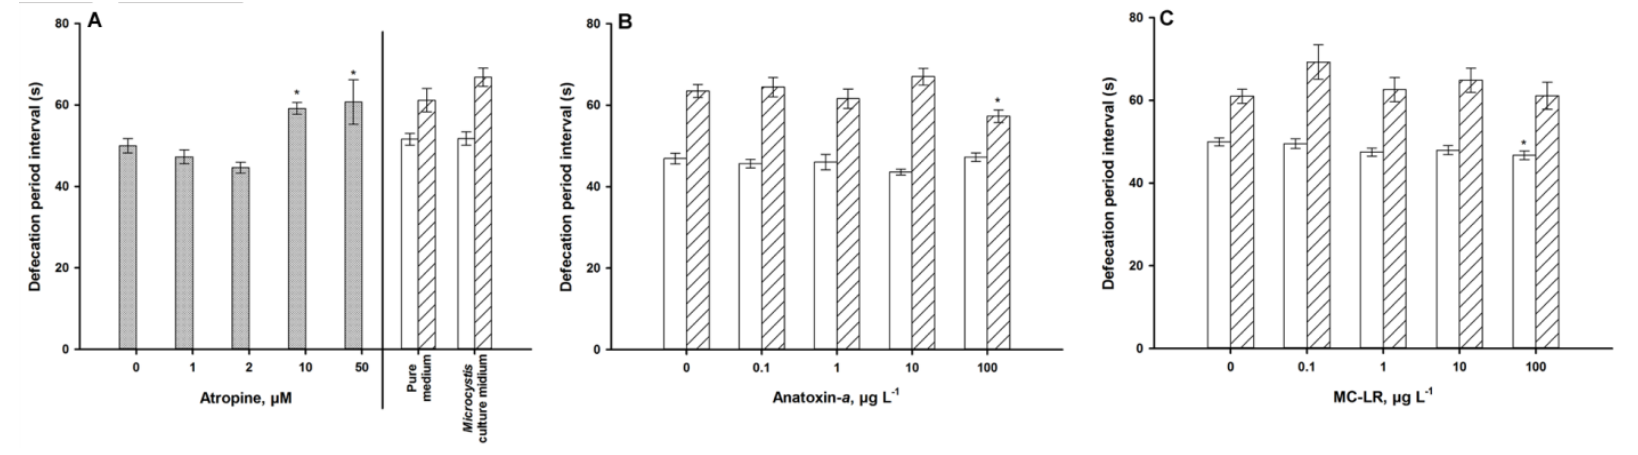
Figure 6. Defecation of young adults. ( A ) exposure to atropine only for 1 h ( grey ) and a Microcystis culture filtrate for 24 h ( white ) and 72 h ( hatched ). ( B ): exposure to anatoxin- a for 24 h ( white ) and 72 h ( hatched ). ( C ): exposure to microcystin-LR for 24 h ( white ) and 72 h ( hatched ). * = p < 0.05, ** = p <